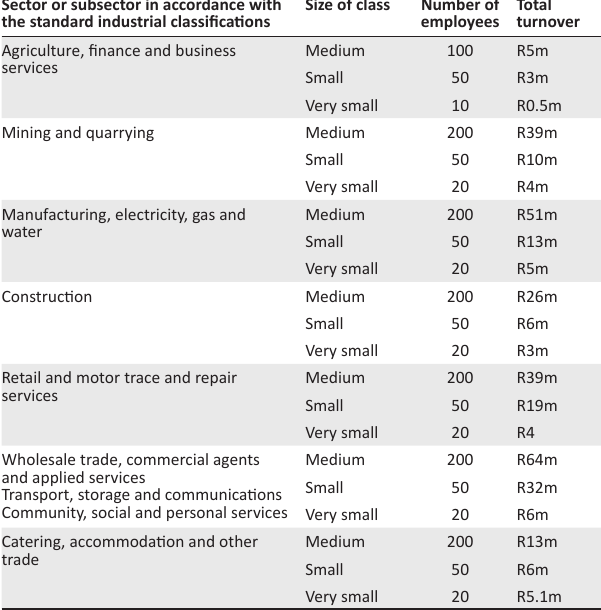
TABLE 1: Schedule of size standards for the definition of small and medium-sized enterprises in South Africa. Sector or subsector in accordance with the standard industrial